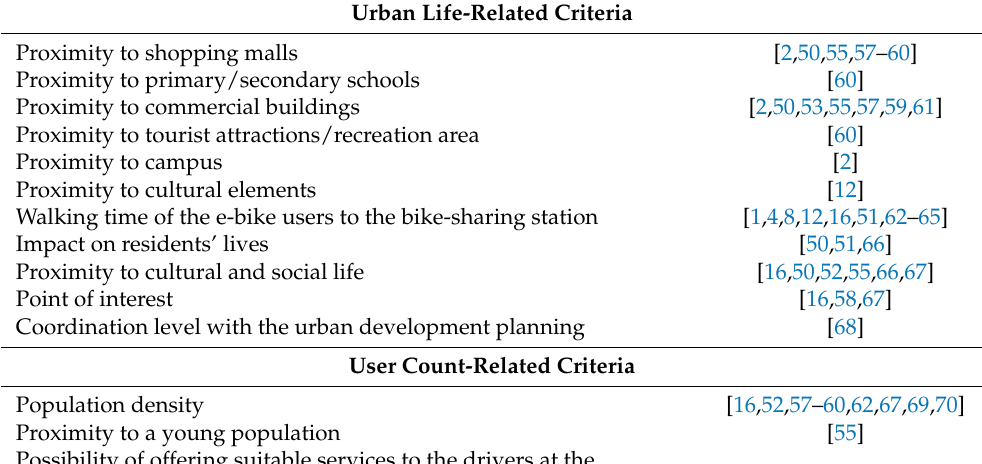
Table A1. Evaluation criteria system for the site selection of e-BSS. Urban Life-Related